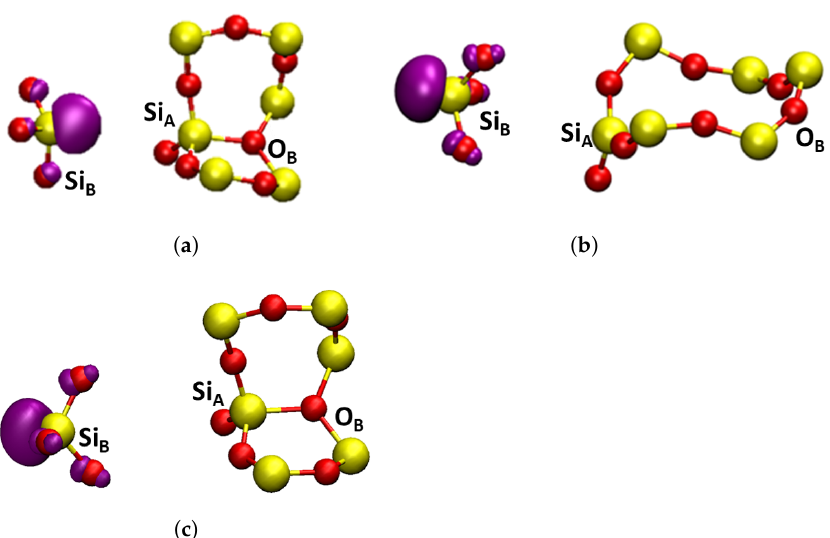
Figure 5. Square modulus of the wavefunction of the highest occupied state in the studied oxygen E (cid:48) defects shown in purple, the isosurface shown is | 0.1 | . Yellow atoms are silicon and red atoms are oxygen. ( a ) E (cid:48) , α -quartz puckered, forward projected; ( b ) E (cid:48) puck ( c ) E (cid:48) , α -quartz, puckered, back bp